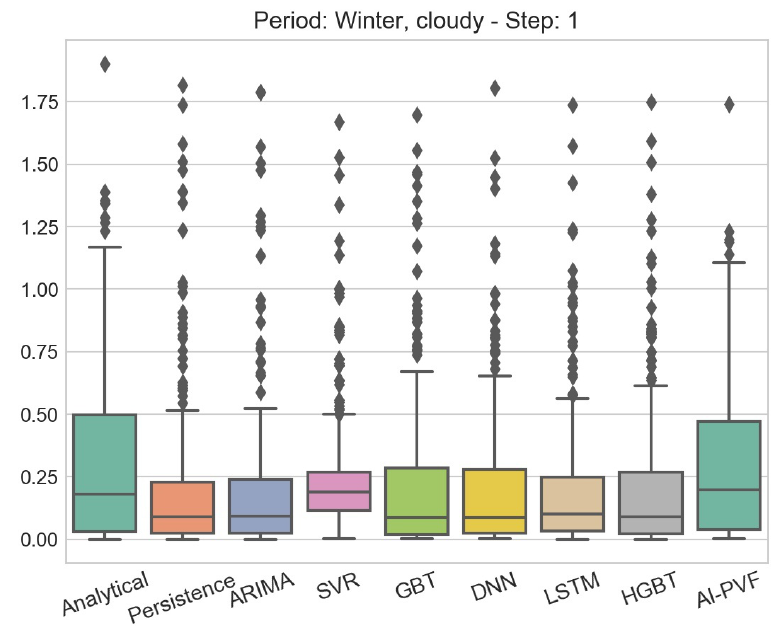
Figure 5. Boxplot of residuals for all PV power generation forecasting models. The data partition examined in this case is the cloudy days subperiod of the winter season and the forecasting horizon is 1 step ahead.